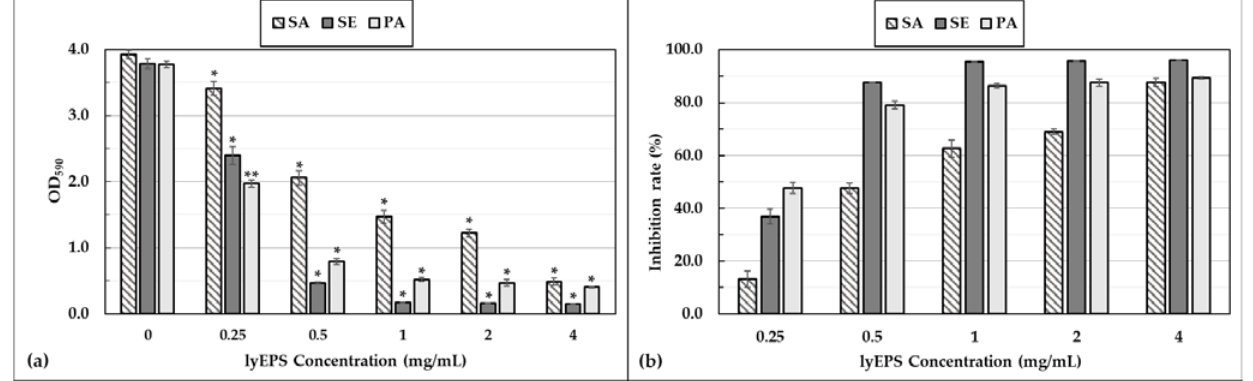
Figure 7. Antibiofilm activity of lyEPS at different concentrations (0, 0.25, 0.5, 1, 2, and 4 mg/mL). The biofilm inhibitory effect of lyEPS on Staphylococcus aureus subsp. aureus ATCC 6538, Staphylococcus epidermidis KACC 13234, and Pseudomonas aeruginosa ATCC 15442 was assessed at OD590. It shows that the OD590 measured value decreases with the increasing concentration of lyEPS ( a ). The inhibition rate was calculated as the relative increase (%) in comparison with the control group (0%, without lyEPS). The inhibition rate increased with increasing lyEPS concentration ( b ). Significant differences between treatments and the control were represented by “*”, p < 0.01; “**”, p < 0.001.